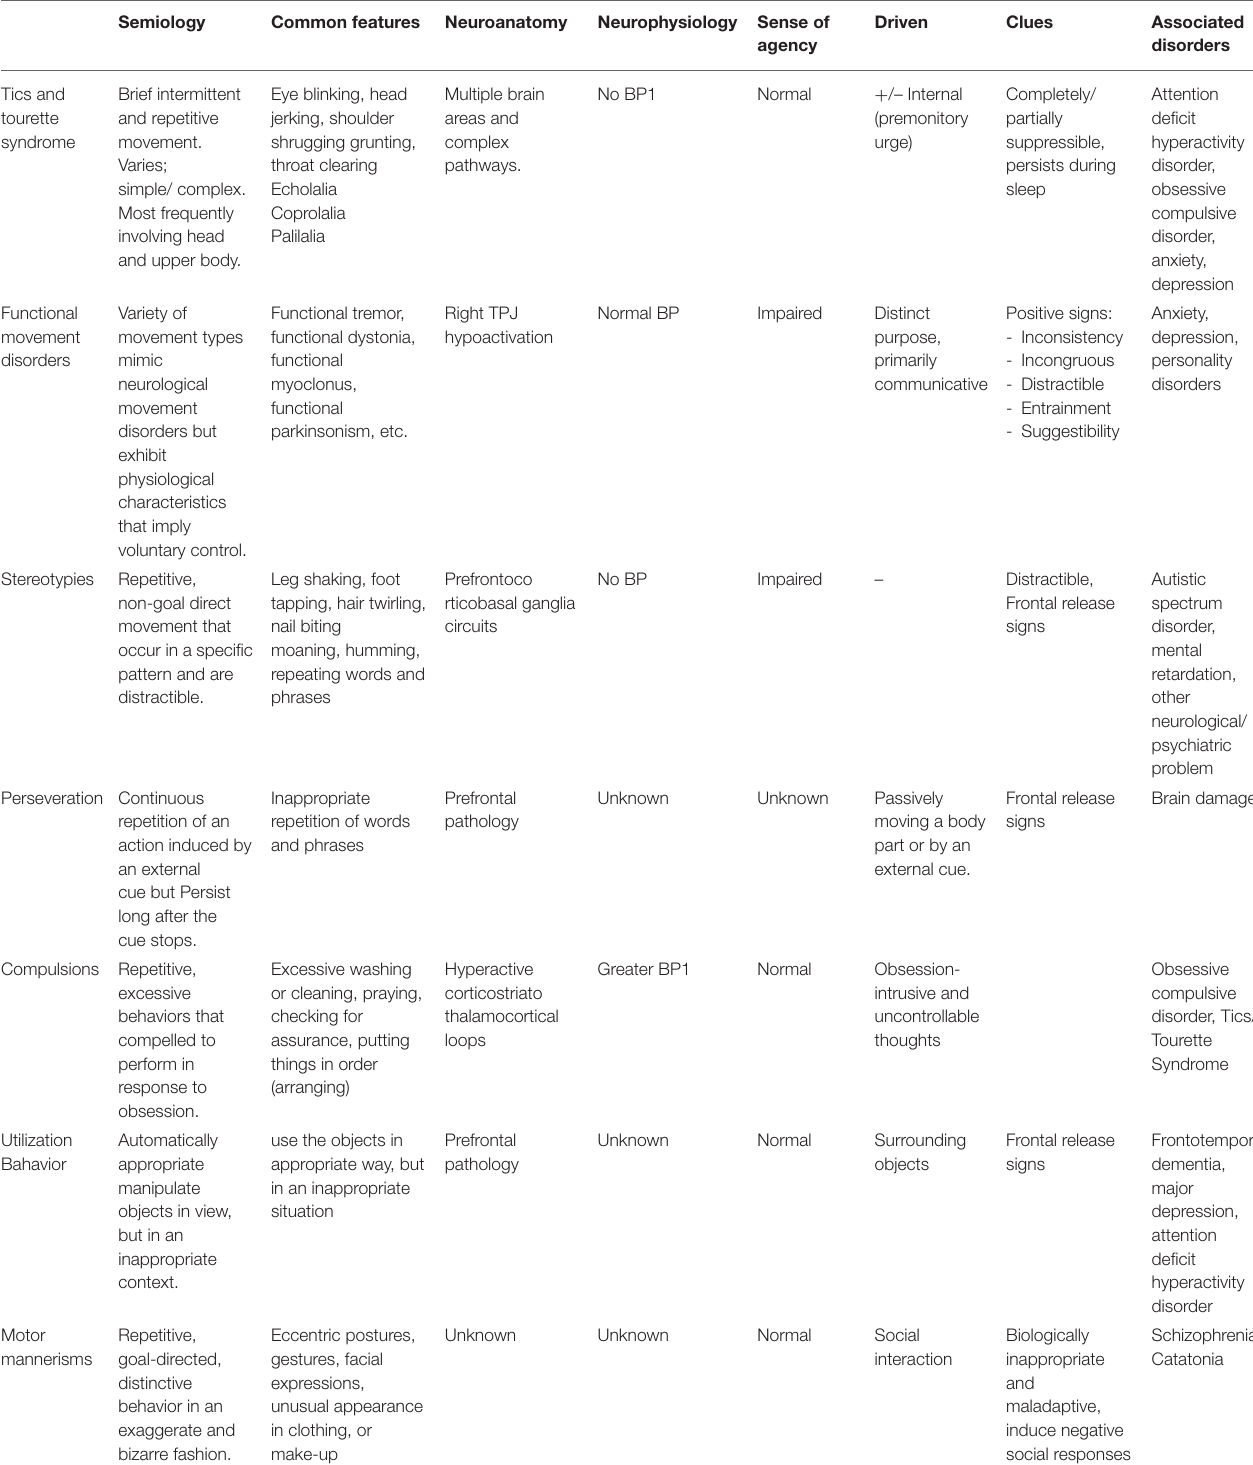
TABLE 1 | Different types of semivoluntary movements with associated behavior manifestation.